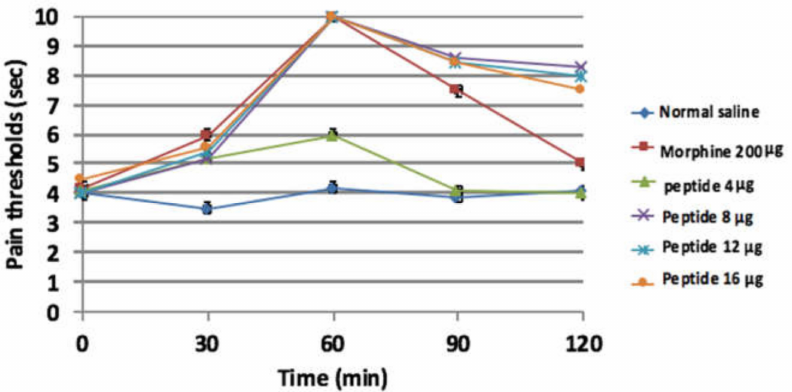
Figure 10. Tail-flick assay. The mice were treated by leptucin or morphine. The maximum analgesic activity of leptucin was obtained after 60 min at the doses of 0.32, 0.48, and 0.64 mg/kg (8, 12, and 16 µ g/mouse). This result was similar to morphine ( p > 0.05). Data are expressed as mean ± SD. All groups had n =